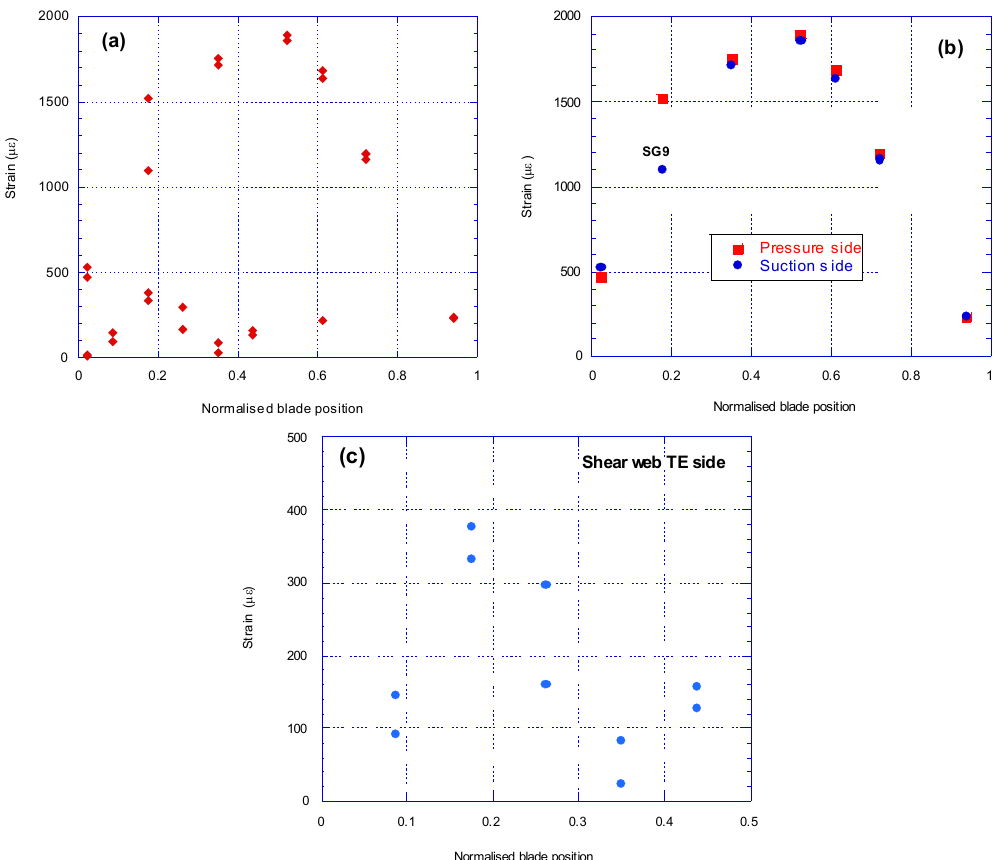
Figure 12. Strains along the as received blade at the first cycle of fatigue test: ( a ) all 30 strain gauges; ( b ) only for gauges on pressure and suction side and ( c ) only for gauges on the shear web on TE side.